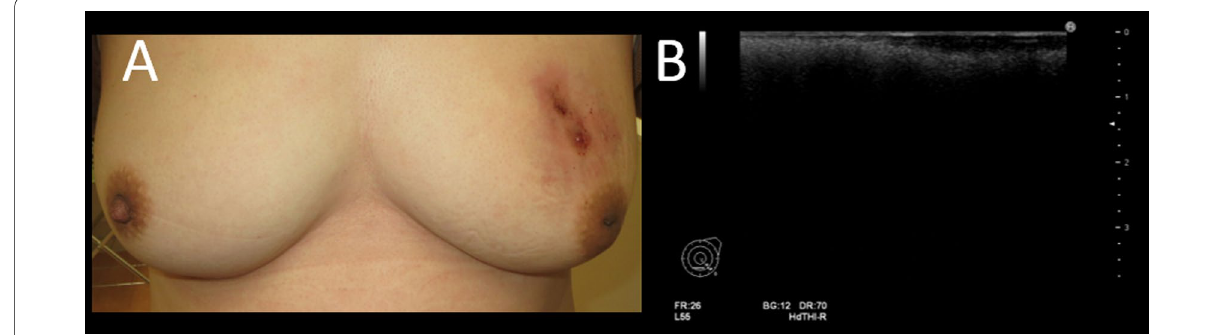
Fig. 1 Skin findings and ultrasound images at initial examination. A Skin of the left breast was partially destructed and there was leakage of pus and serous fluid. B It was difficult to observe the depth due to strong backward echo caused by foreign